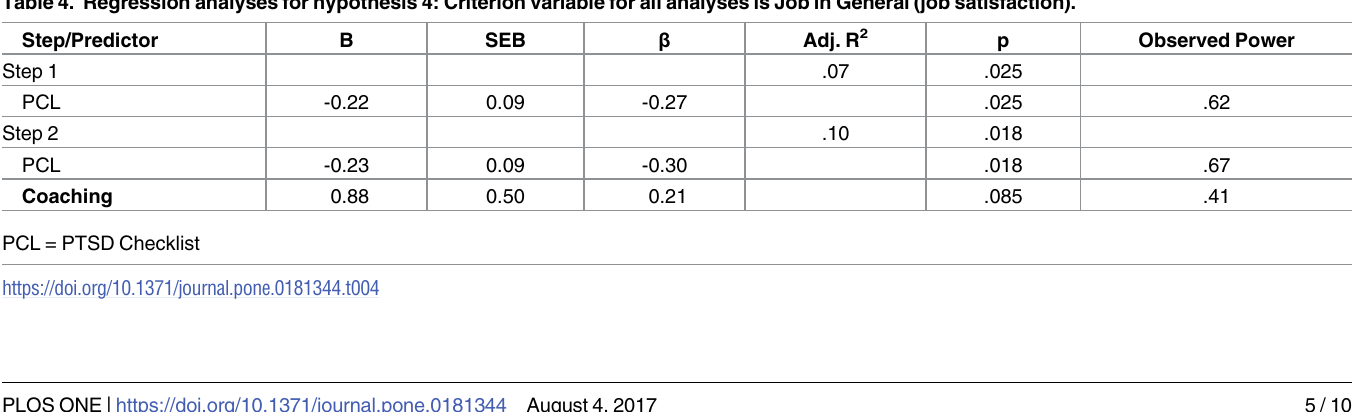
Career Mentoring